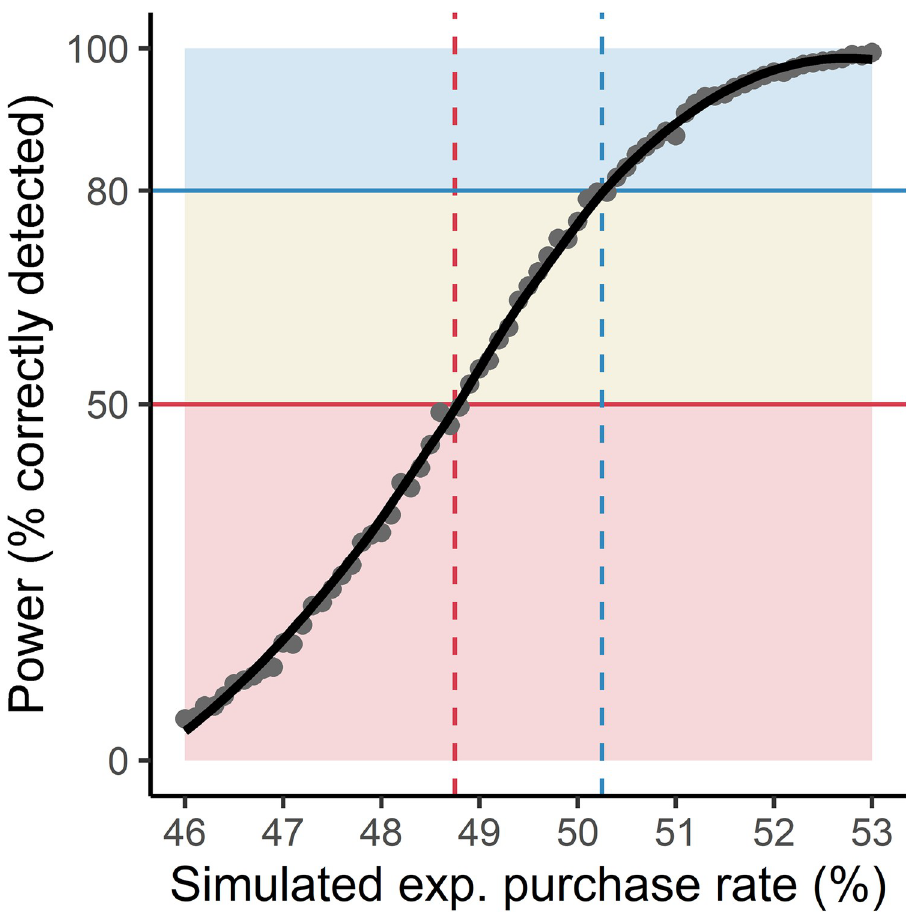
Fig 4. Results of the posthoc power analysis. Each dot represents the percentage of correctly detected effects (i.e., statistical power) across 2500 simulated experiments. Each simulated experiment contained 266 fictive participants who had a 45.3% probability of purchasing the control ticket and a variable probability of purchasing the experimental ticket. The solid black line represents a best-fit curve through these points.